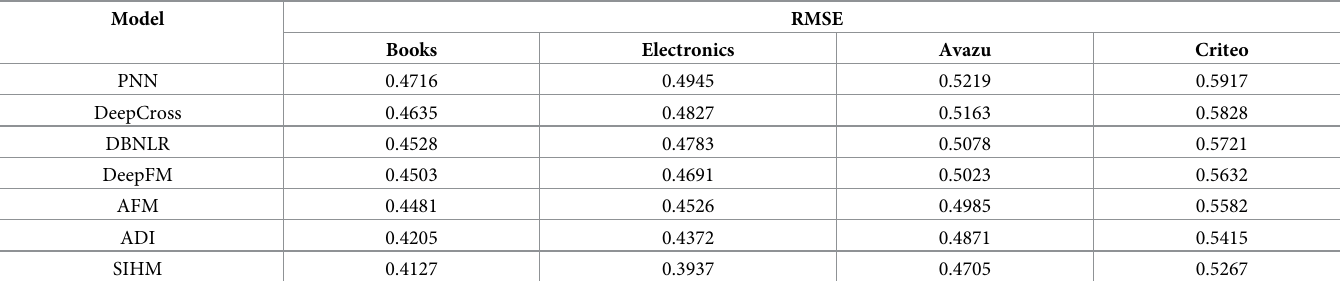
Table 3. Overall CTR prediction for RMSE performance in different datasets. Model